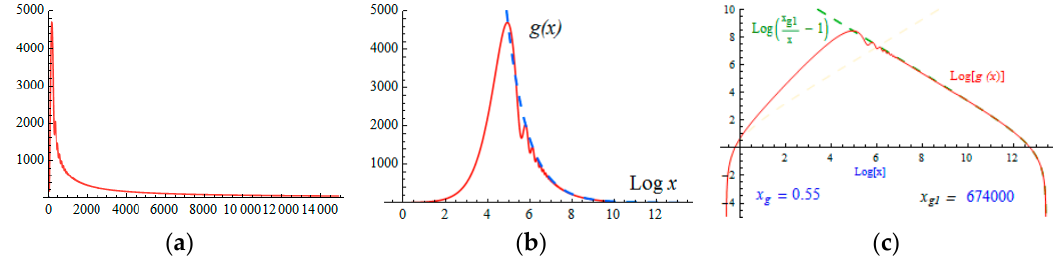
Figure 9. Metric function g( x ): ( a ) linear scale, ( b ) log(x) scale, ( c ) double-log scale.